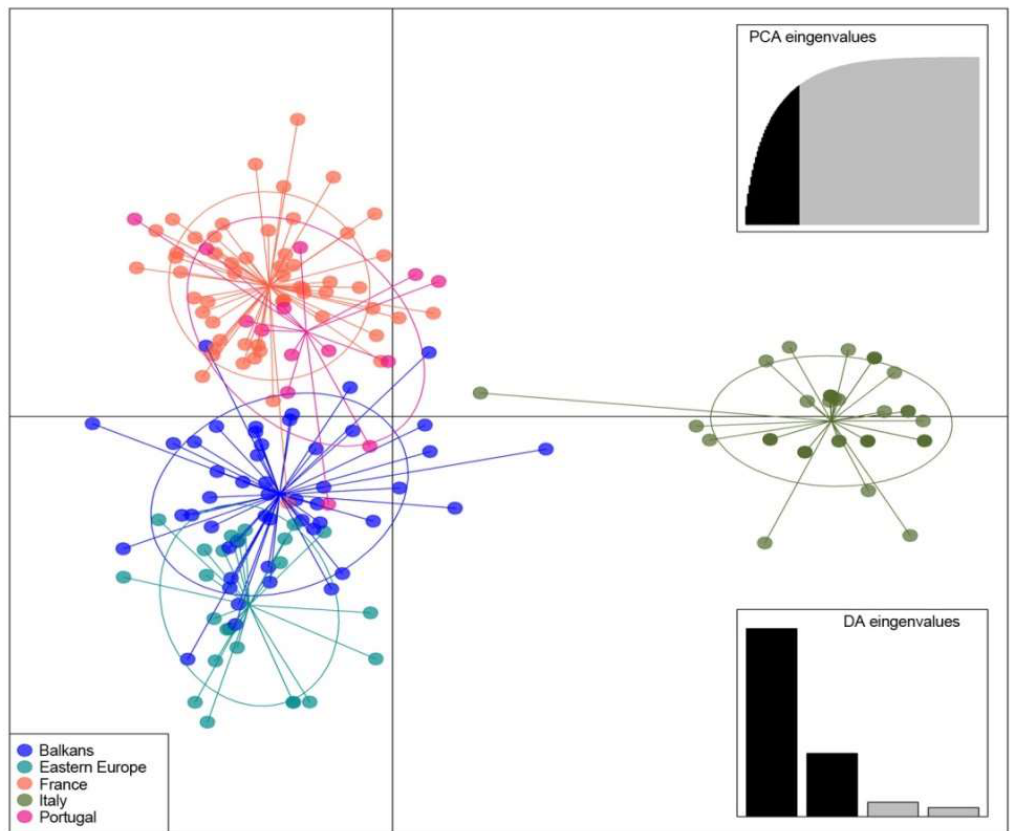
Figure 4. DAPC clustering of European germplasm of F. angustifolia studied, using the first two principal components ( Y -axis and X -axis, respectively). The samples are grouped in five main groups: Balkans (blue; Croatia, Macedonia, Montenegro, Serbia, and Turkey), Eastern Europe (cyan; Bulgaria, Hungary, and Ukraine), France (orange), Italy (green) and Portugal (pink).